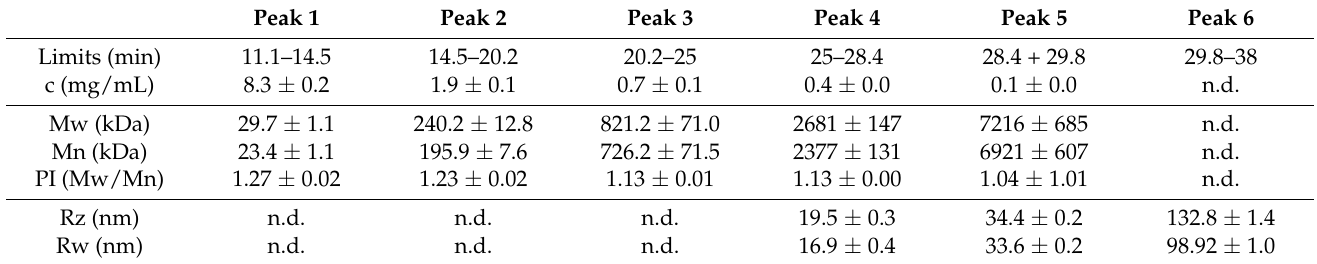
Table 5. Results of analysis of dark beer (50 µ L original and 100 µ L 1:1 diluted sample mea- sured each in triplicate). Values are given as average and standard deviation of all measurements ( n = 6). Note that different peak settings have been applied compared to the values given in Table 4. n.d. = not